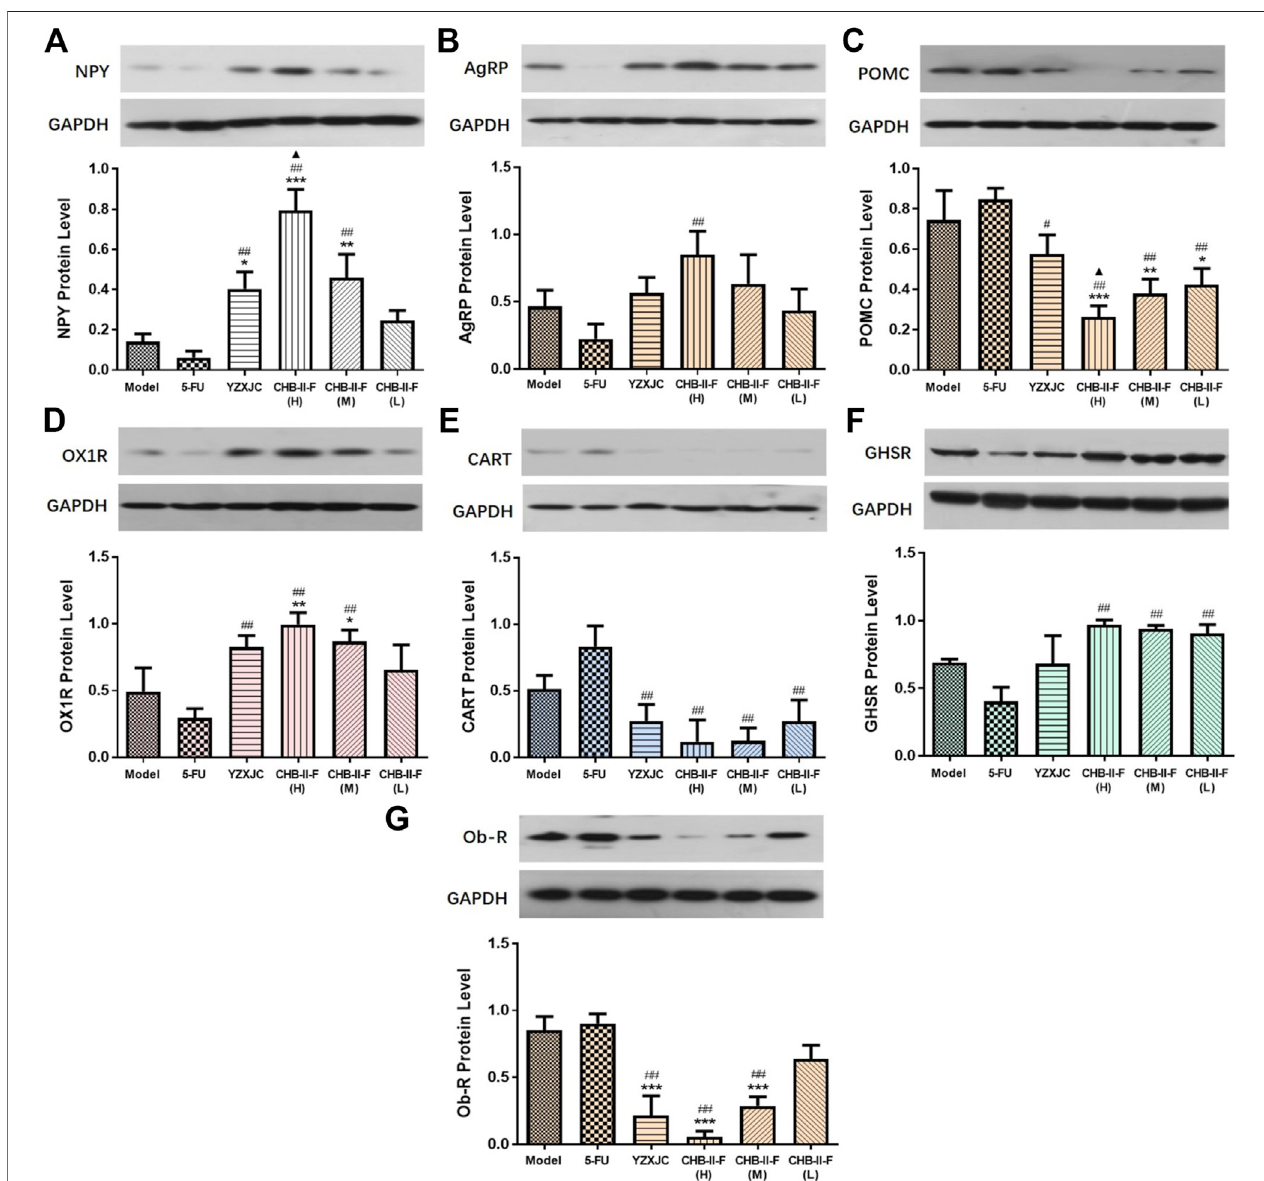
FIGURE 5 | Effects of CHB-II-F on protein expression of NPY, AgRP, POMC, CART, OX1R, Ob-R, and GHSR in the hypothalamus of the transplanted H 22 hepatocellularcarcinomamodelmicereceivingchemotherapy( x ± s ,n (cid:2) 6).Statisticalanalysis:* p < 0.05,** p < 0.01,*** p < 0.001comparedwiththemodel(saline)group. # p < 0.05, ## p < 0.01 compared with the 5-FU group, ▲ p < 0.05 compared with the YZXJC group.